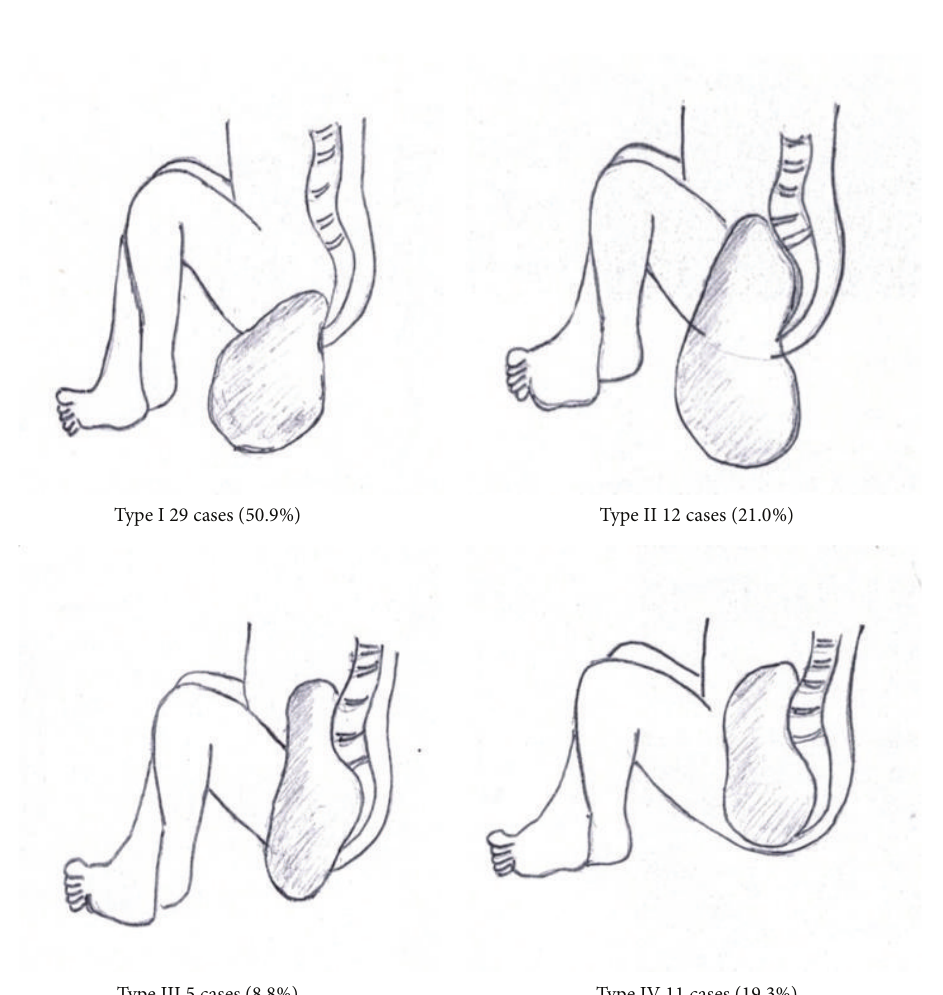
Figure 2: Classification system for 57 sacrococcygeal germ cell tumors based on Altman’s American Academy of Pediatrics series [7].